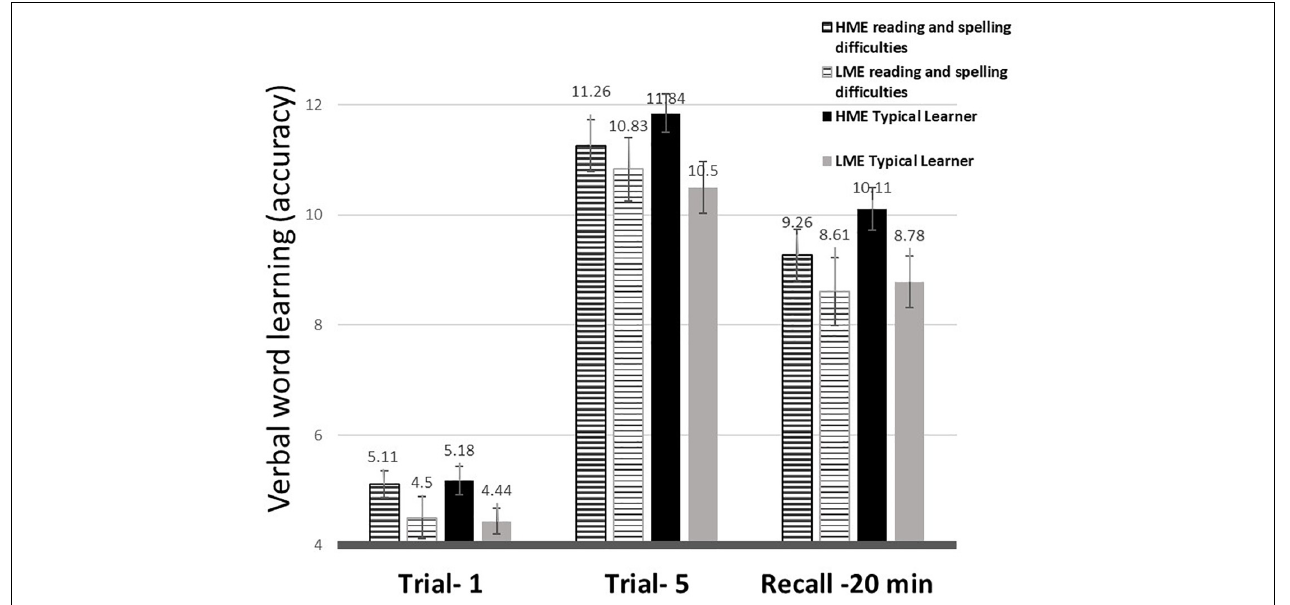
FIGURE 5 | Verbal word-learning (accuracy, mean and standard deviation ) trajectory in the four groups: HME reading and spelling difficulties , reading and spelling difficulties with high maternal education; LME reading and spelling difficulties , reading and spelling difficulties with low maternal education.